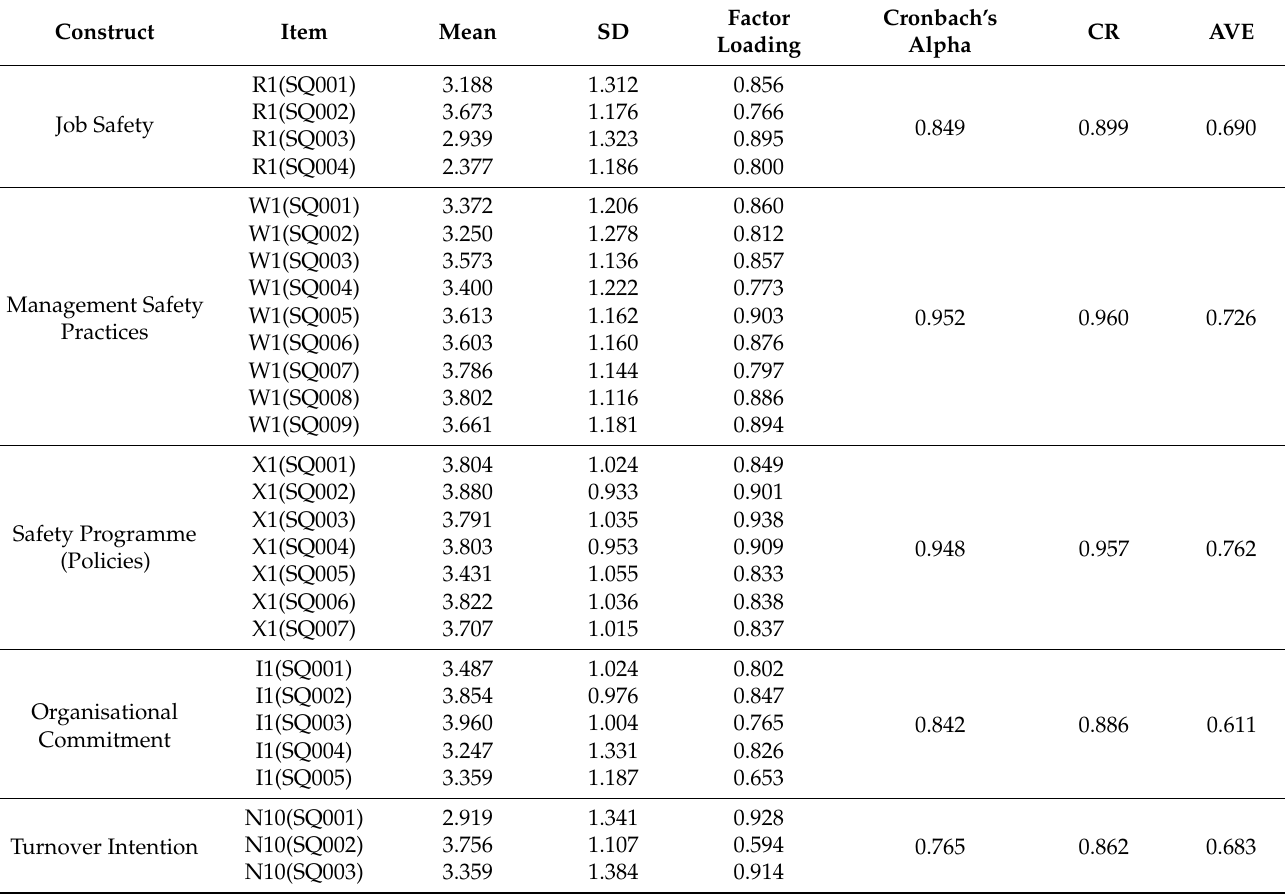
Table 1. Factor loadings, means, standard deviations, reliabilities, and average variance